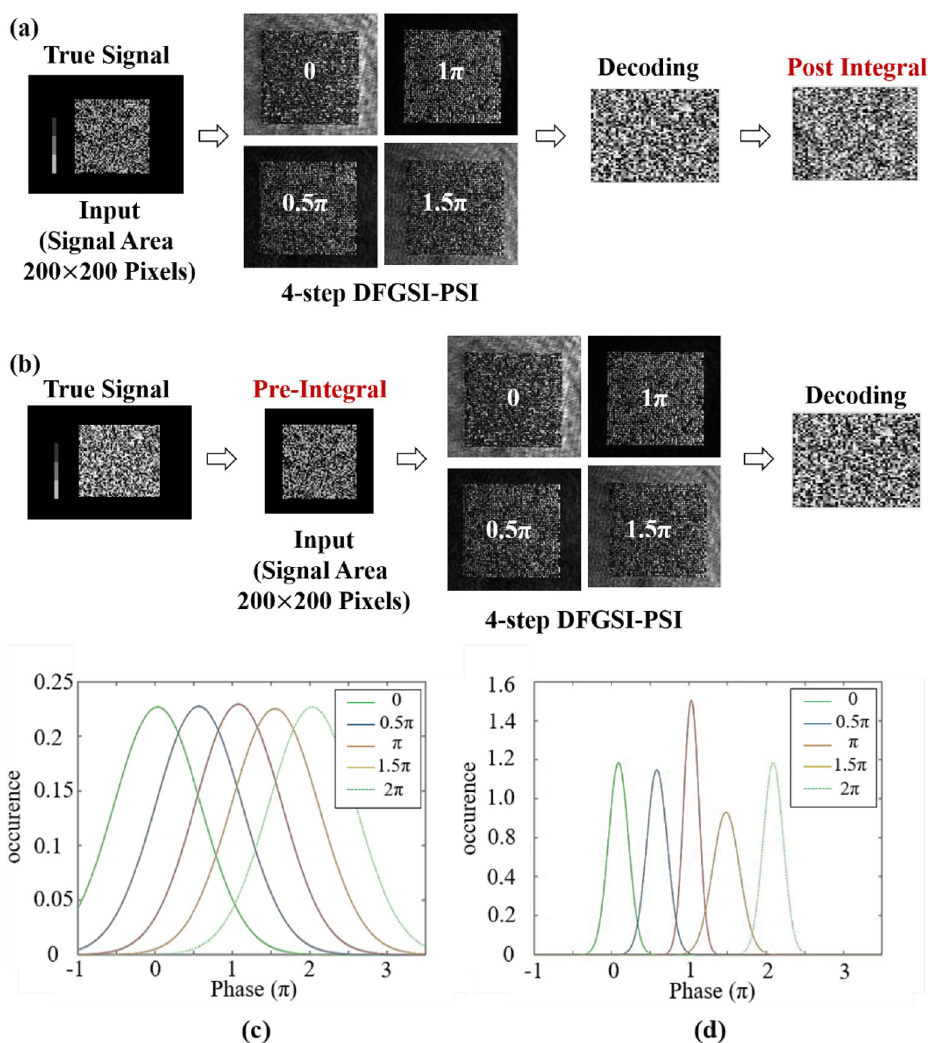
Figure 8. (a) The experiment of DFGSI-PSI with post integral, (b) the experiment of pre-integral–DFGSI-PSI, ( c ) the experimental results of phase retrieval of DFGSI-PSI with post integral, and (d) the experimental results of phase retrieval of